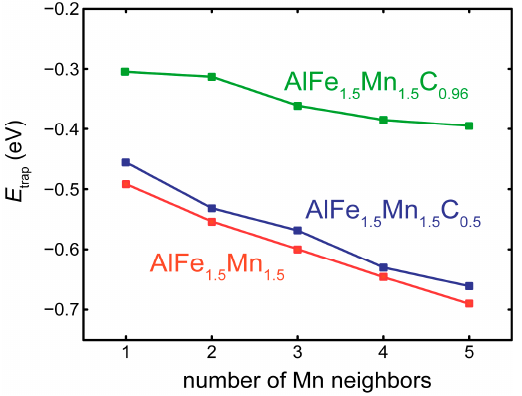
Figure 4. Trapping energy E trap of a single H atom as a function of the number of Mn atoms in its first CS for a 3 × 3 × 3 L 1 2 -Fe 1.5 Mn 1.5 Al supercell with C sublattice concentrations of 0% (red), 50% (blue), and 96% (green).